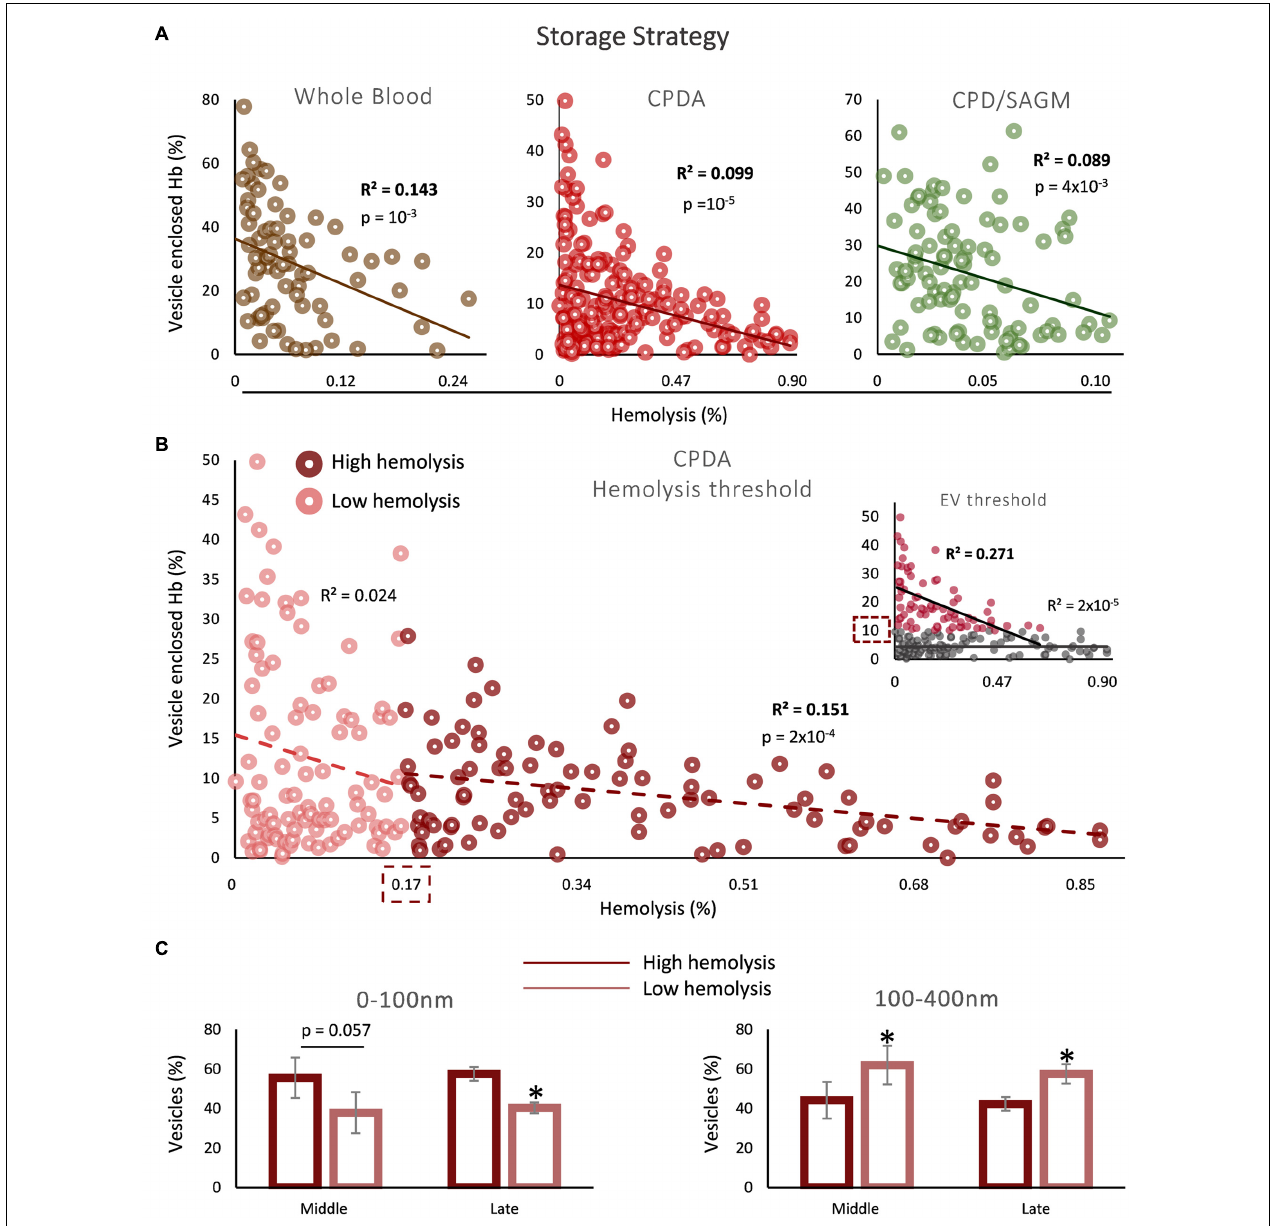
FIGURE 2 | Correlation between vesicle-enclosed Hb and storage hemolysis in blood bank conditions. (A) Scatter plots showing the correlation between total free and vesicle-enclosed Hb in whole blood, CPDA and CPD-SAGM units, from mid-storage onward. (B) Threshold analysis in CPDA blood units. The dashed boxes indicate the hemolysis or EV-Hb percentage (insert) values that serve as cutoffs. (C) Dynamic light scattering (DLS) analysis in selected CPDA samples of high and low hemolysis (above and below the threshold, respectively; n = 5 per group) during middle and late storage (horizontal axis). ∗ p < 0.05, high vs low storage